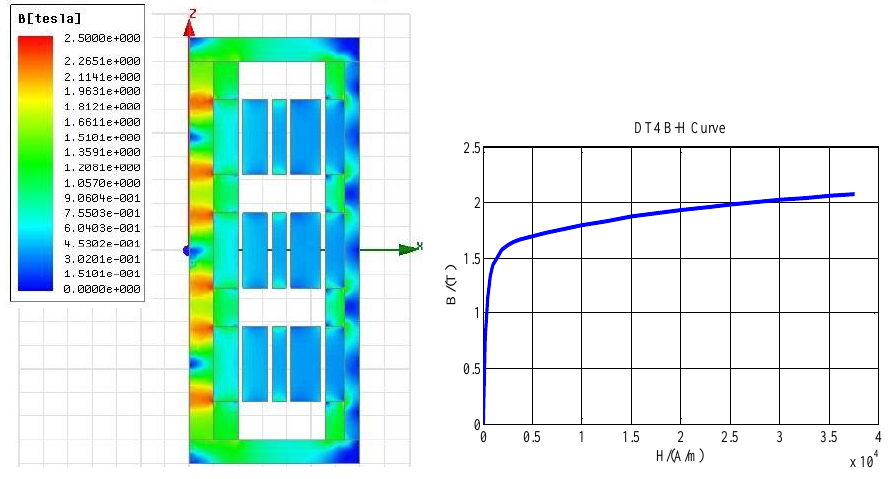
Figure 8. Flux density in the linear machine and BH curve of back iron.